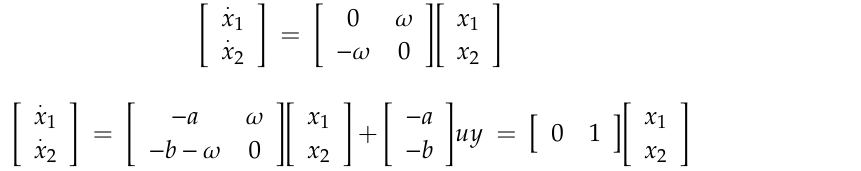
Figure 5. Single-phase sinusoidal Oscillator.